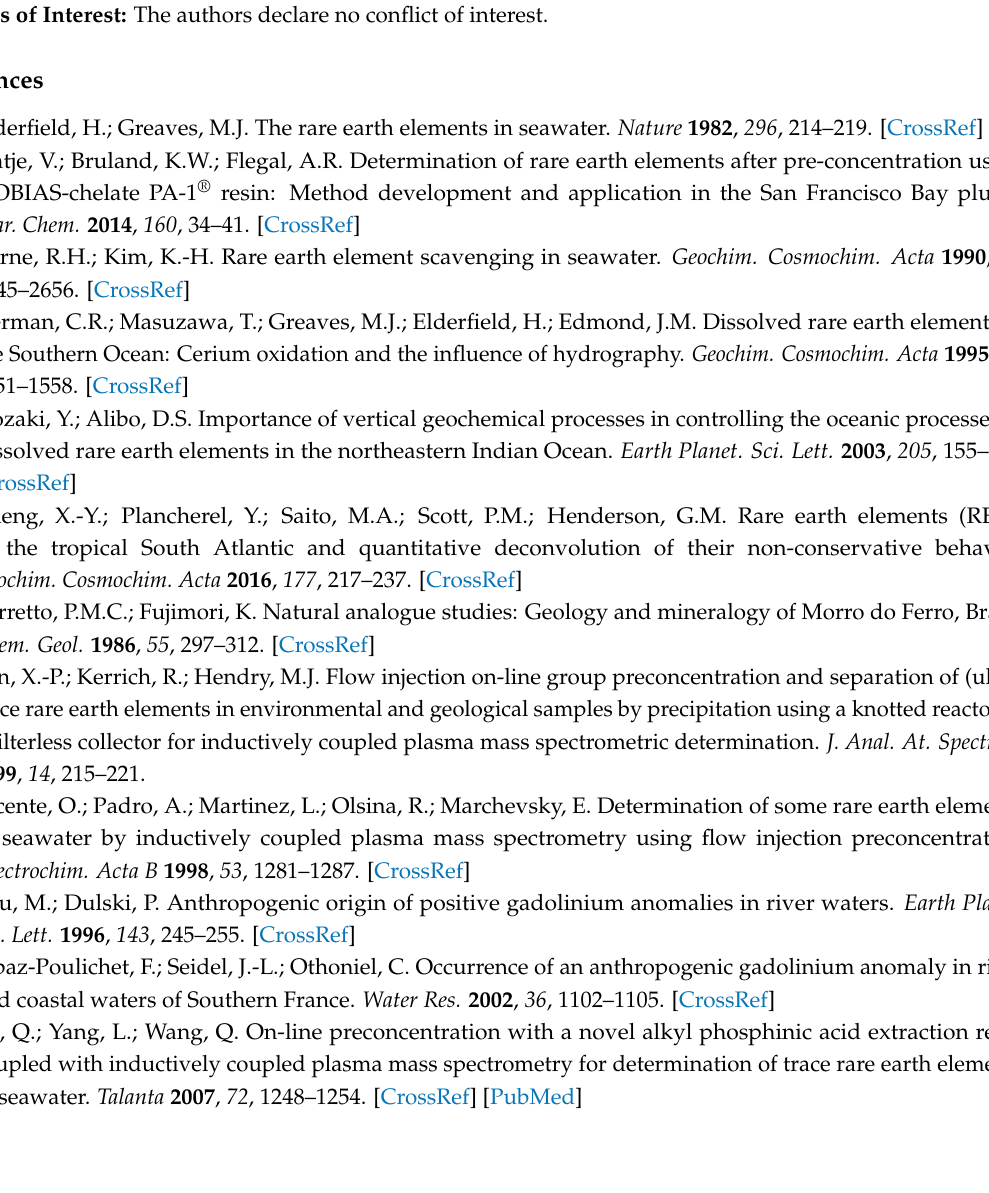
Supplementary Materials: The following are available online, Table S1: Percentage of REEs peak area (%) of different loading rates to peak area of 1.5 mL min -1 . Table S2: Relative coefficients (R 2 ) between REEs peak areas and loading times. Table S3: REEs concentrations measured by the presented method from samples collected in the Jiulong River Estuary (water samples were collected in April 2015). Table S4: REEs concentrations measured by the presented method from samples collected in Taiwan Strait (seawaters were collected at the station